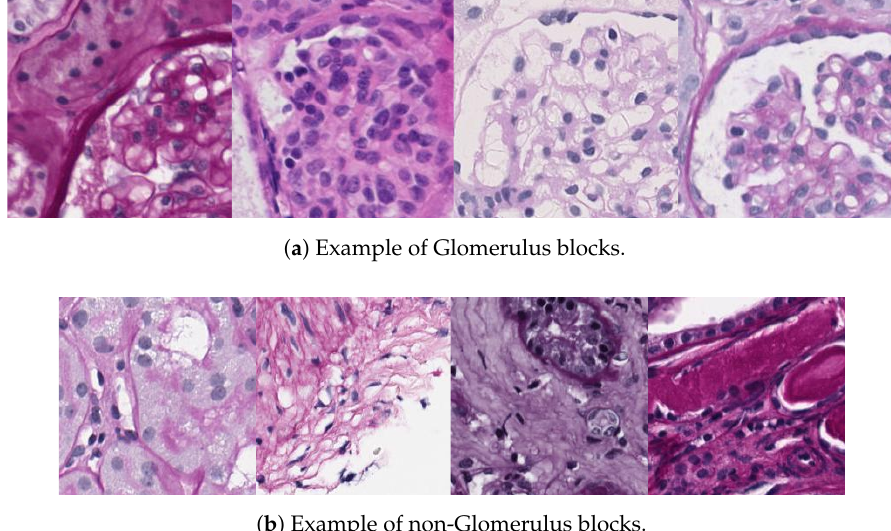
Figure 4. Example of 227 × 227 pixels training blocks for Glomerulus and non-Glomerulus